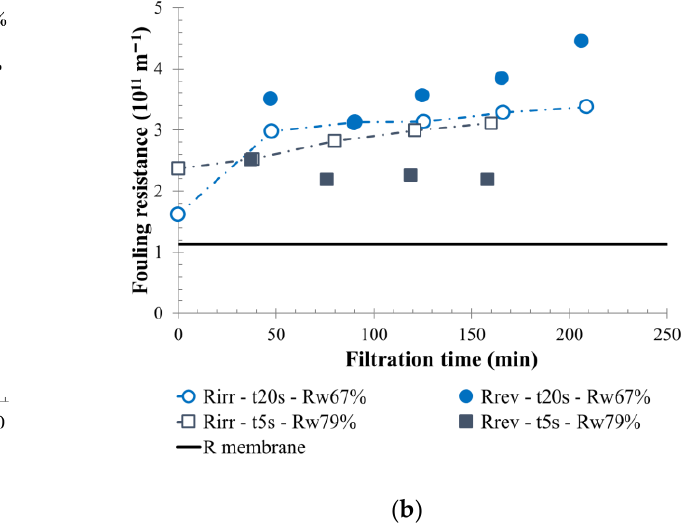
Figure 8. Influence of BW duration on membrane filtration behavior by variation of permeability at